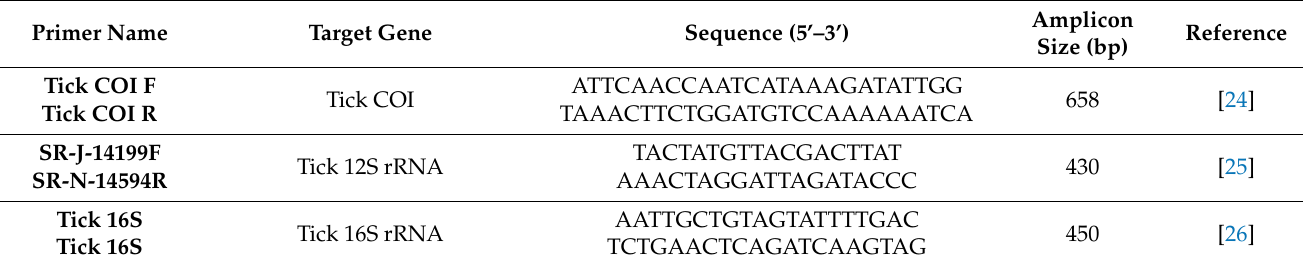
Table 1. Primers used for molecular identification of ticks and tick-borne